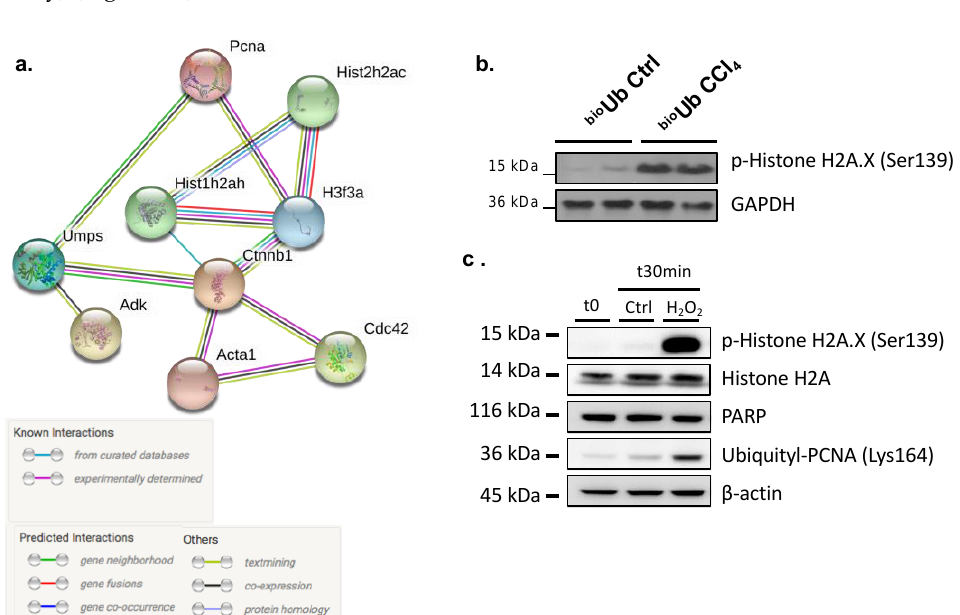
Figure 6 M. Mercado et al.